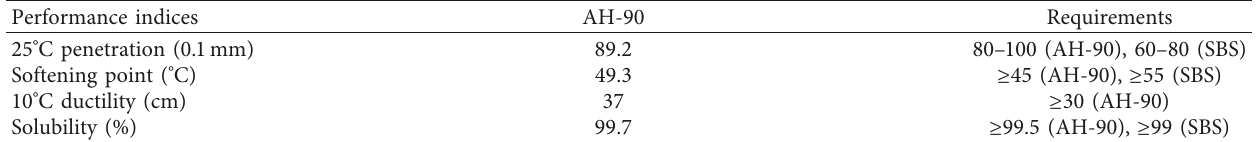
Table 2: Technical properties of AH-90 asphalt.